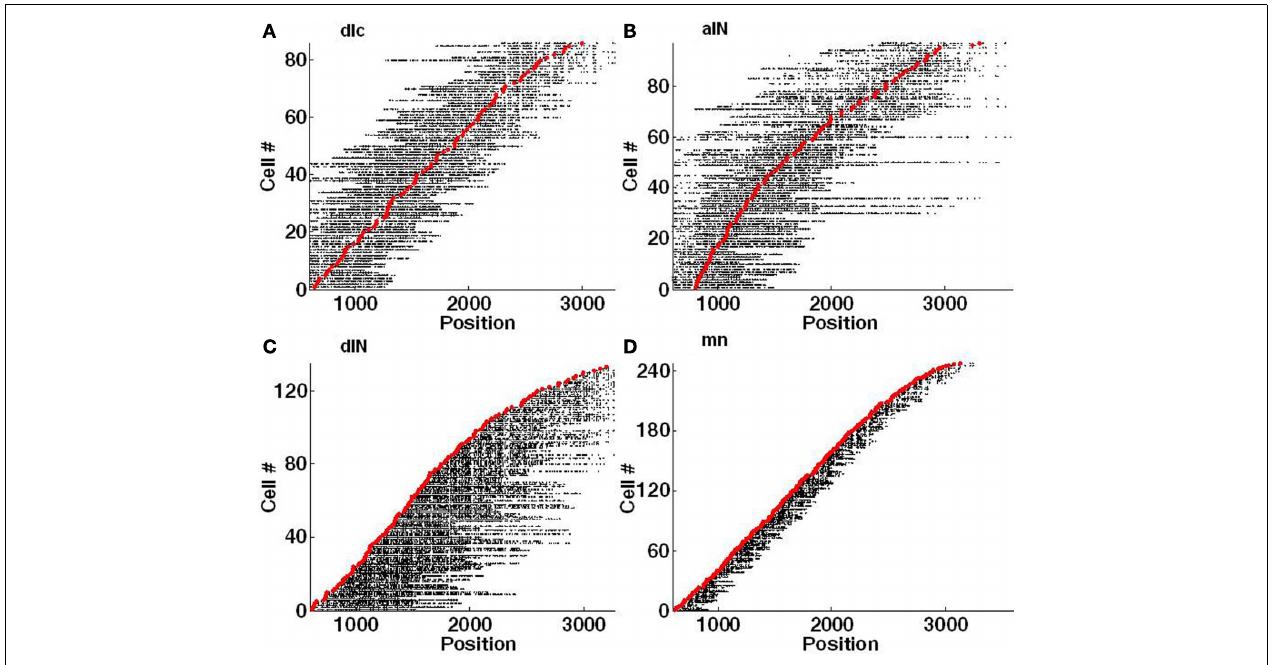
the head) and synapses on the right side are located on a descending axon (toward the tail). (A) dlc. (B) aIN. (C) dIN; note that the ascending axons present on a few spinal cord dINs were not included in this connectome. (D) mn.